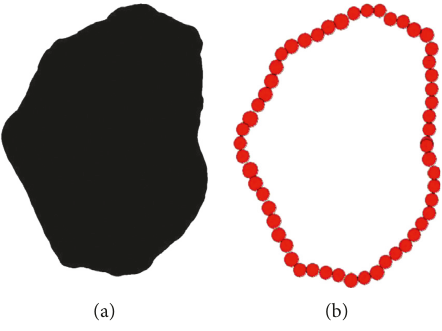
Figure 3: Rebuilding virtual particles by filling contours with